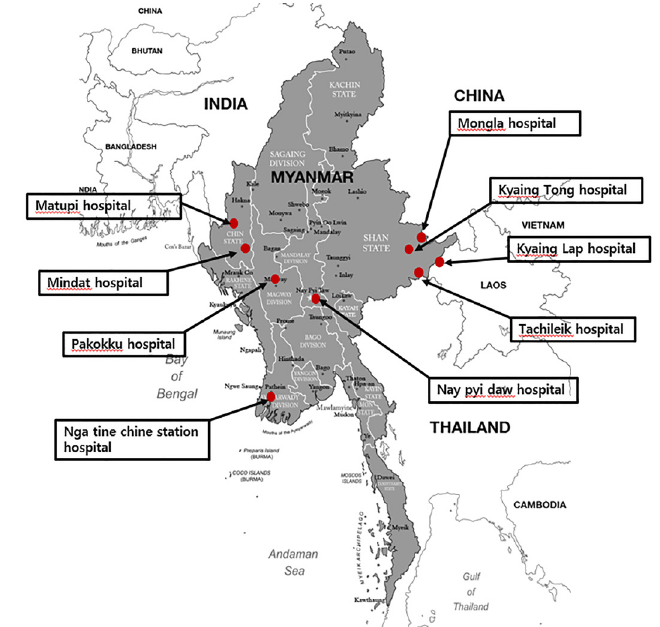
Figure 1. Geographical distribution of hospitals